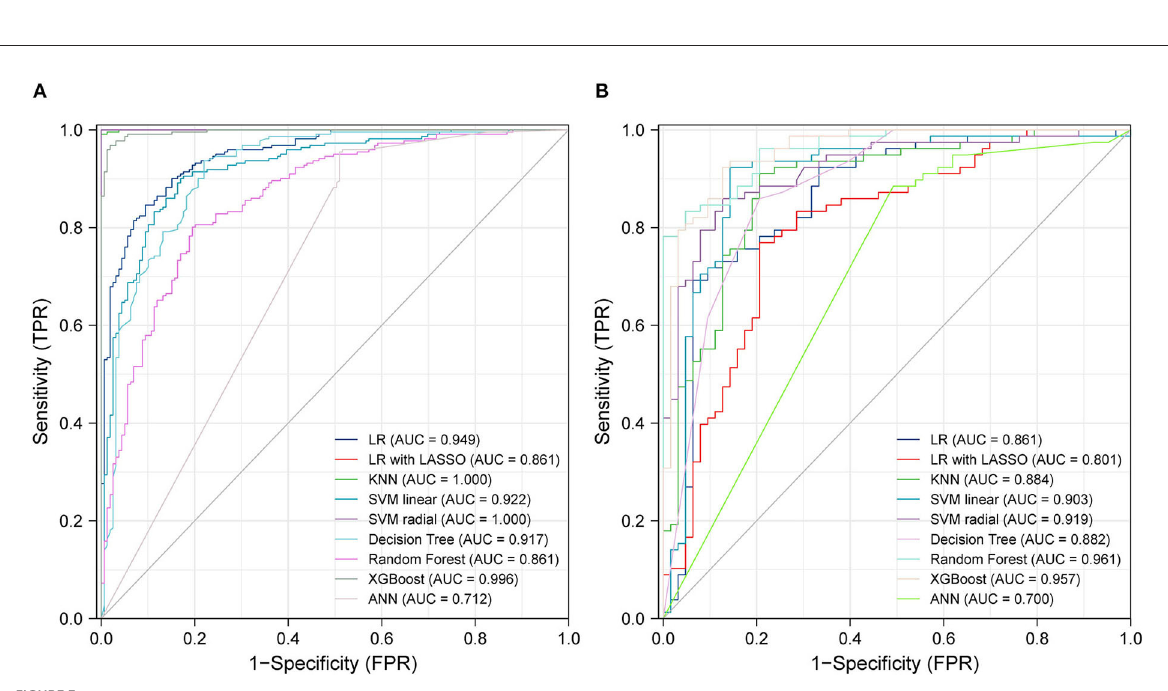
FIGURE3 ROC curves from training test (A) and testing test (B) using different machine learning algorithms. Legend including area under receiver operator characteristic curve for each algorithm with 95% confidence intervals. LR, logistic regression; LASSO, the least absolute shrinkage and selection operator; KNN, K-nearest neighbor; SVM, support vector machine; XGBoost, extreme gradient boosting; ANN, artificial neural